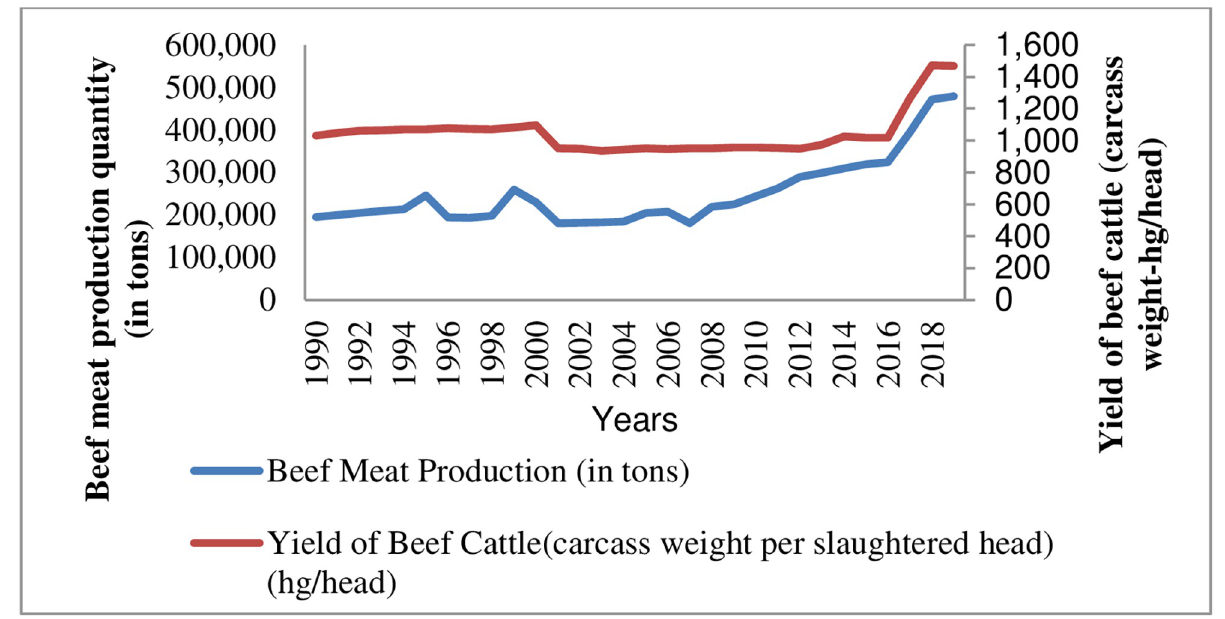
Fig 2. Beef meat production and carcass yield trends in Tanzania (1990–2019).